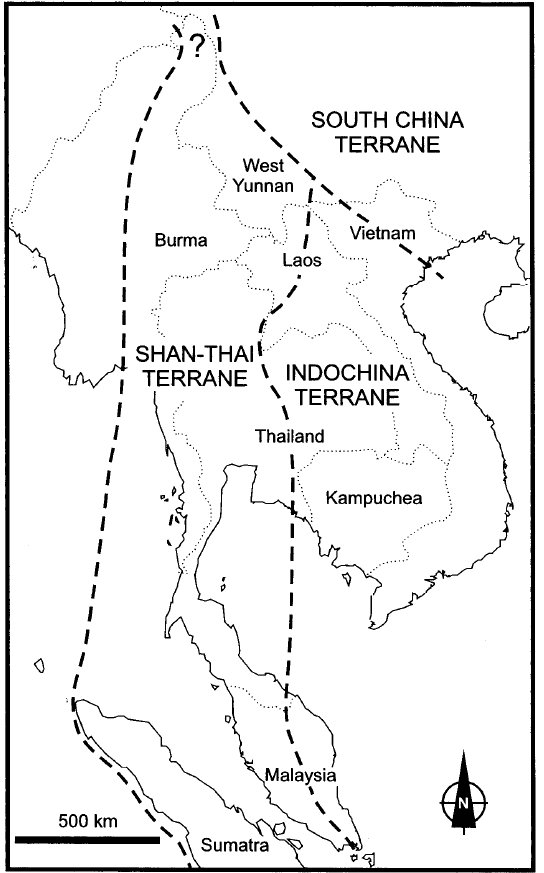
Figure 7. The main geoblocks in Southeast Asia (from Fortey et al., 1998). The Indian plate moved northward and collided with the Eurasian plate in the early Cenozoic period (about 50 Ma (million years) ago), leading to the formation and uplift of the Himalayas [68]. With the Himalayan uplift, the Indochina geological plate was extruded toward Southeast Asia [69–73], ending in the late Miocene (10 Ma) [74]. Meanwhile, the Simao-Lanping geoblock in Yunnan moved toward the southeast with the Indochina